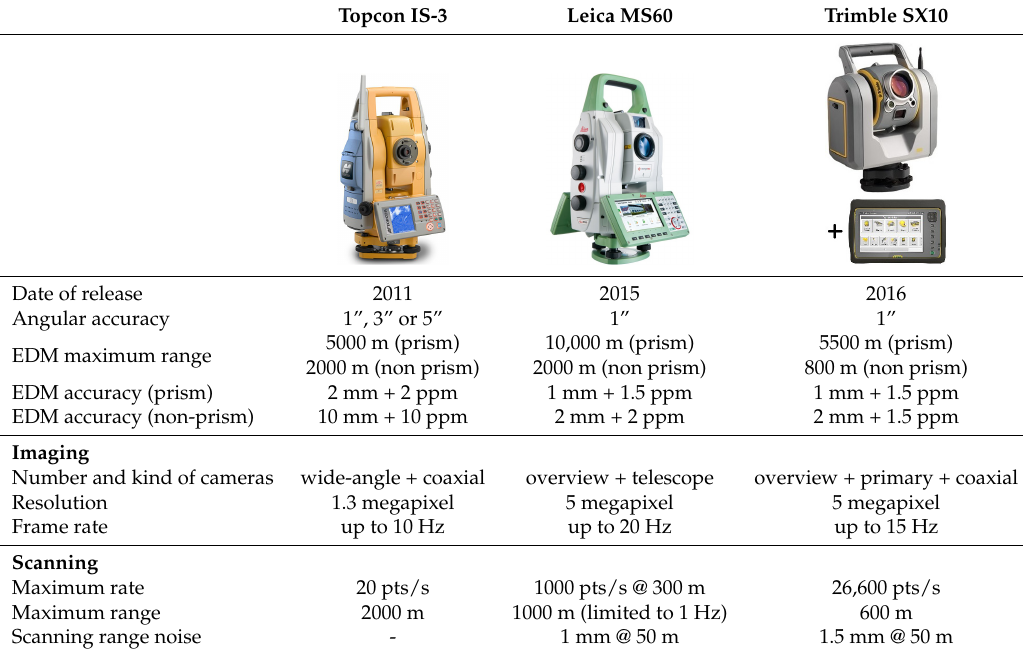
Table 1. Overview of scanning total stations with some of their technical specifications according to